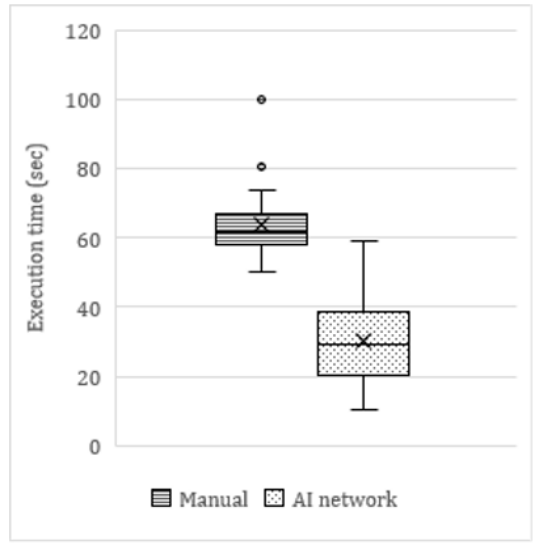
Table 4. Average manual refinements to the network calculations. M1, M2, and M3 = first, second, and third molar, respectively. Min. = minimum; Max. = maximum.